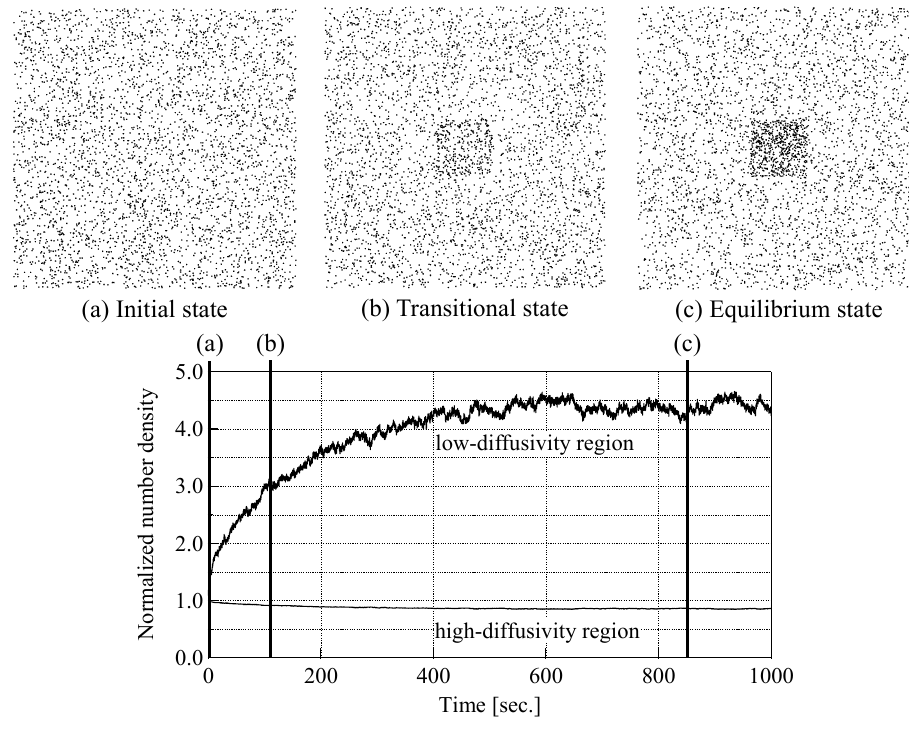
Fig. 3 (a)–(c) Snapshots of GPIb α diffusing on a platelet membrane. Each dot corresponds to single GPIb α molecule. (d) Number densities of GPIb α molecule at low-diffusivity localized region and high-diffusivity non-localized region normalized by initial state distribution of dissociation forces is clearly bimodal because of the 2 different dissociation pathways. In this study, only the first pathway, which has the same mechanism as that at lower pulling rates, was considered. Fig. 4 is a schematic illustration of the calculation model for the experiment by Kim et al. In this model, only the bond breakage event was included for 10000 GPIb α –vWF bonds. with updating l – l in Eq. (5) according to the pulling Simulations were conducted from l = l 0 0 rate until all the bonds broke. The unbinding force distributions were obtained from the unbinding distance distributions of GPIb α –vWF bonds by using Eq. (1). The unbinding force distributions normalized by the greatest number of bond breakages shown in Fig. 5 are corroborated by the experimental results when k = 0.9 k . ts